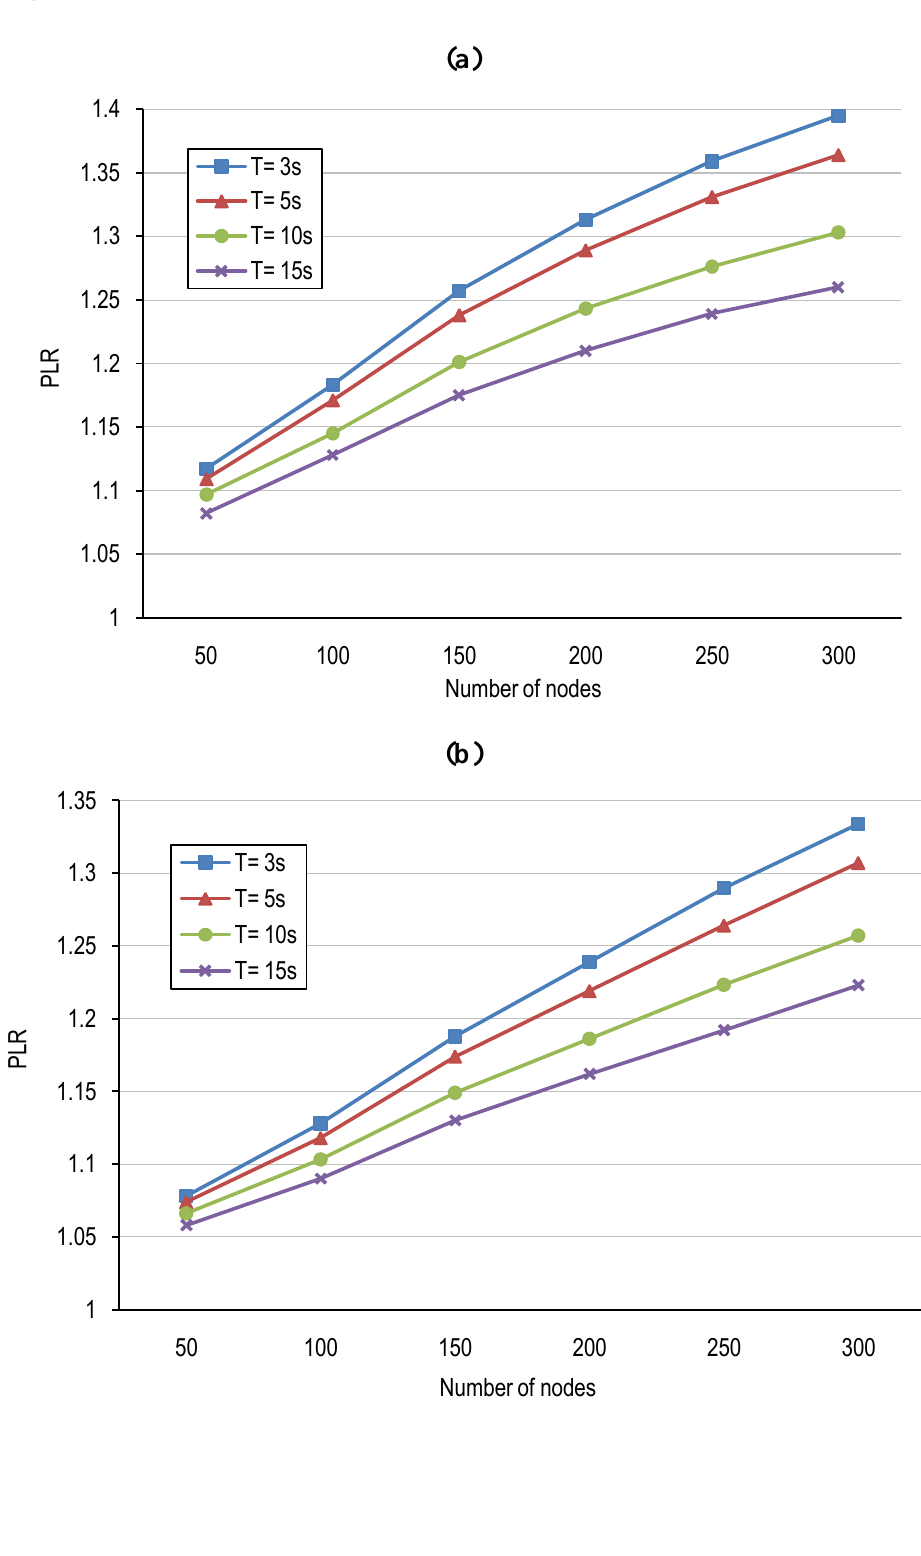
Figure 14. Prolongation Lifetime Ratio (PLR) for different node densities in the clustered tier with an overlapping scale equal to (a) 0.5. (b) 0.6, in four states of base awakening